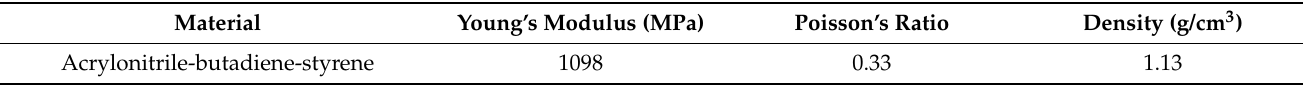
Figure 4. Hammer experiment process block diagram.